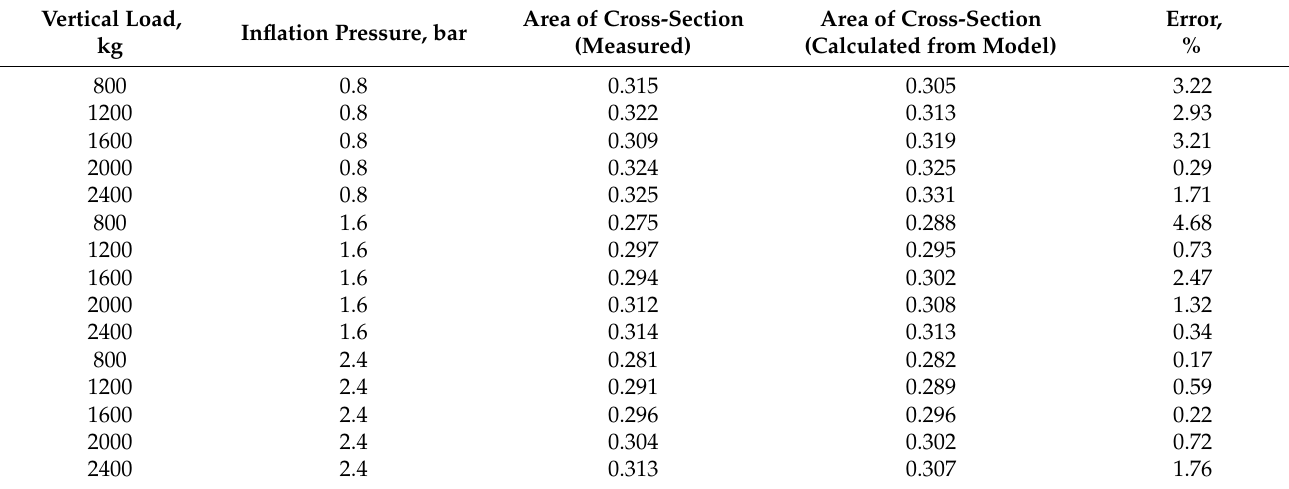
Table 5. Verification of mathematical model for radial